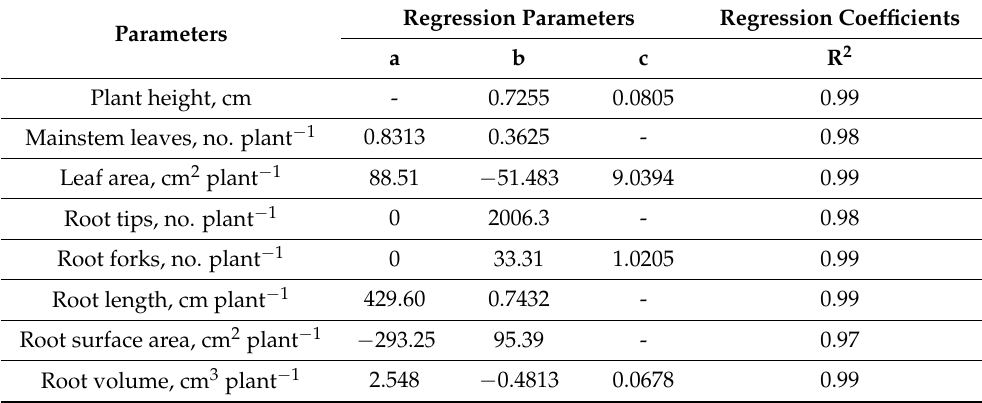
Figure 9. Estimated potential corn growth and developmental parameters from the fitted modified beta functions model as temperature at various harvests. Table 4. Regression parameters and coefficients of corn estimated maximum growth values over time at optimum temperature for all shoot and root morphological parameters of corn (Y = a + bx for linear; Y = a + bx + cx 2 for quadratic), where Y is the plant parameter and x is days after